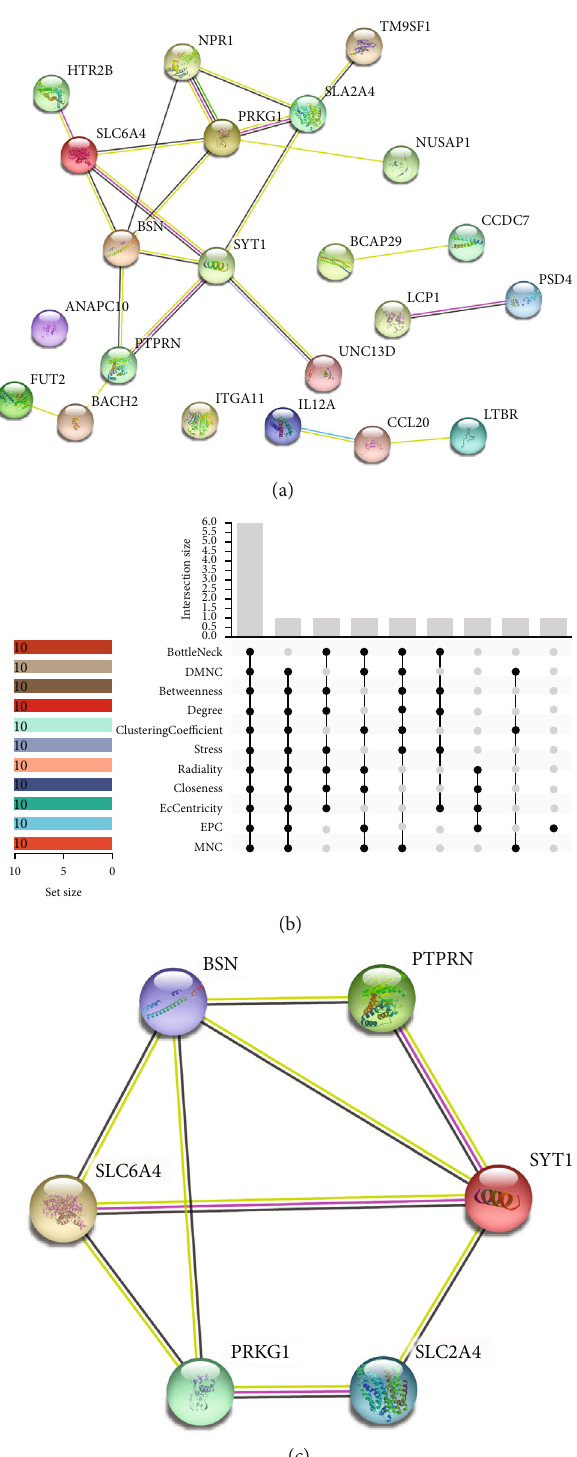
Figure 4: PPI network construction and hub gene selection. (a) PPI network construction. (b) Hub gene selection. (c) PPI network of hub